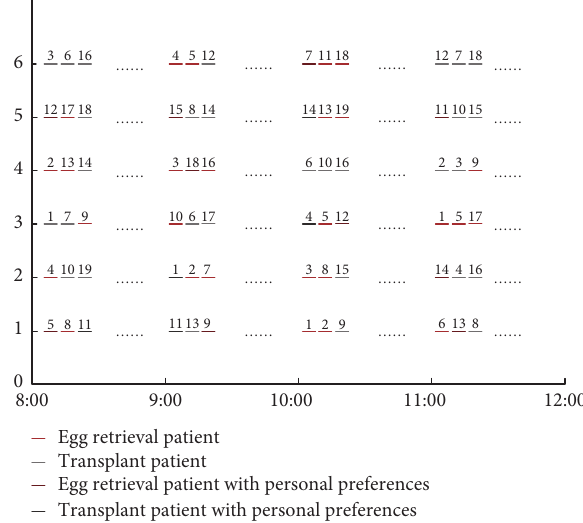
Figure 8: Scheduling Gantt diagram based on Q